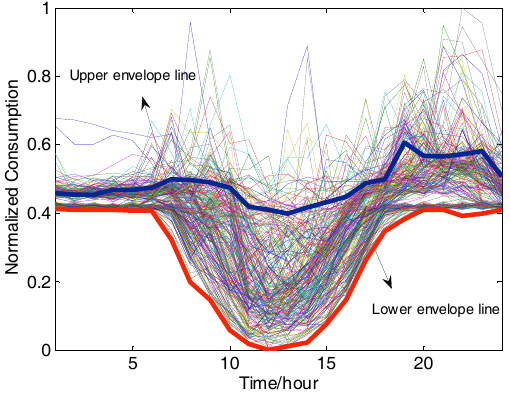
Figure 7. An example of envelope lines extraction.